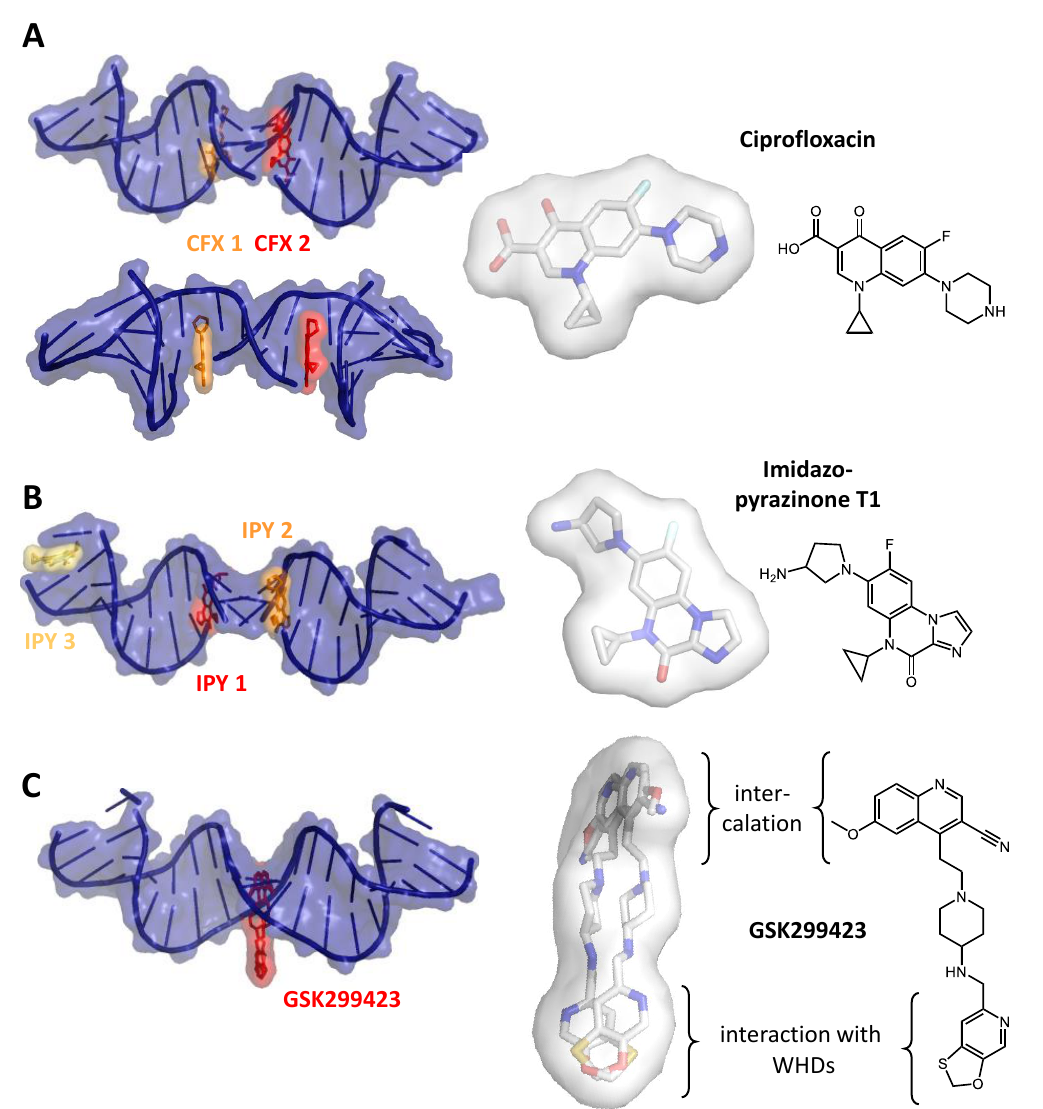
Figure 3. Gyrase poisons. Left: Binding modes. Center, right: Inhibitor structures in stick representation and chemical formula. ( A ) The fluoroquinolone Ciprofloxacin (CFX 1, CFX 2; orange, red) intercalates into the DNA to the left and to the right of the cleavage site [50] . The DNA (blue) is shown in the standard orientation of GyrA (top, see Figure 2B) and rotated (bottom) to highlight the intercalation. ( B ) The Imidazopyrazinone T1 (IPY 1, IPY 2, orange, red) intercalates into the DNA in a similar mode to fluoroquinolones (see panel ( A )) [57] . A third molecule (IPY 3, yellow) is bound at the end of the DNA. ( C ) The NBTI GSK299423 binds on the two-fold symmetry axis of the GyrA dimer and contacts the DNA-gate of GyrA (not shown) through the oxathiolopyridine moiety, and to the G-segment through the quinoline [50] . Two alternate conformations of the NBTI were modeled. PDB-IDs: 2xct ( S. aureus GyrBA fragment bound to Ciprofloxacin), 6fqm ( S. aureus GyrBA fragment with Imidazopyrazinone T1), 2xcs ( S. aureus GyrBA fragment with GSK299423).